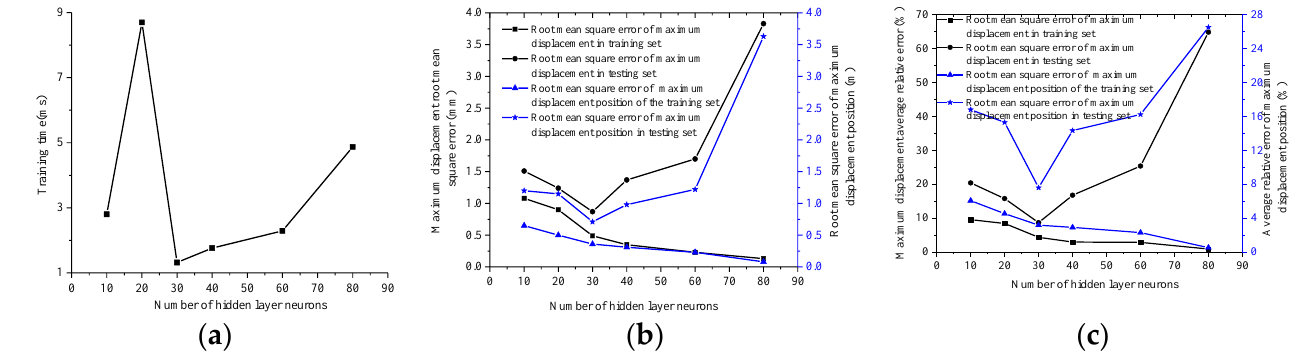
Figure 4. Comparison of the number of neurons in different hidden layers: ( a ) comparison of calculating time; ( b ) comparison of root mean; and ( c ) comparison of average relative error square difference.